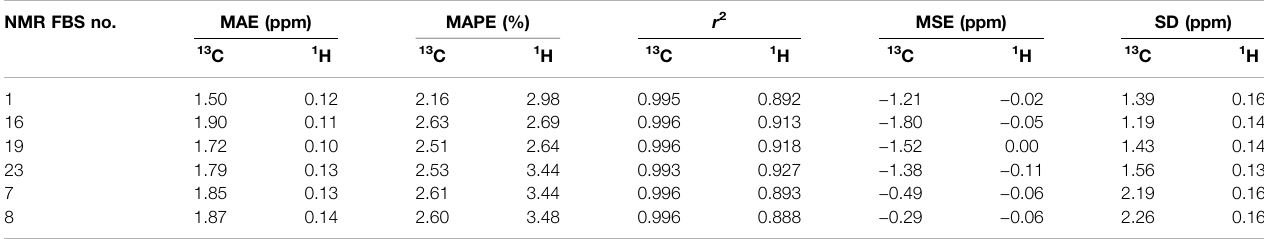
TABLE 3 | Statistical analysis [mean absolute errors (MAEs), mean absolute percent errors (MAPEs), and r 2 values] of the performance of the top 6 nuclear magnetic resonance(NMR)functional – basisset(FBS)combinationsforpredicting 13 Cand 1 HshiftsusingimplicitsolvationduringbothgeometryoptimizationsandNMRshielding constant calculations. NMR FBS